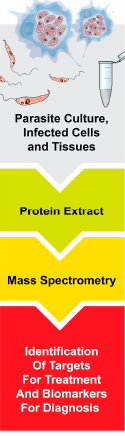
Figure 1. Proteomics approach process. The study of the proteome of Leishmania -infected cells and tissues, using mass spectrometry, can lead to the identification of targets for prophylactic and chemotherapeutic treatment and to the identification of biomarkers that can be used for the diagnosis of different diseases. The aim of the present report is to review the recent contributions of proteomics to the understanding of the various aspects of the Leishmania -mammalian host interaction. We will first describe the contributions made by large-scale proteomic studies on alterations of protein expression in parasites during their differentiation process from promastigotes to amastigotes, followed by studies identifying proteins differentially expressed by host cells and tissues in response to infection. These recent studies explored proteins expressed in macrophage- Leishmania interaction in vitro [22,23], in cutaneous lesions of infected humans [26], as well as in serum of individuals with VL [27–29].